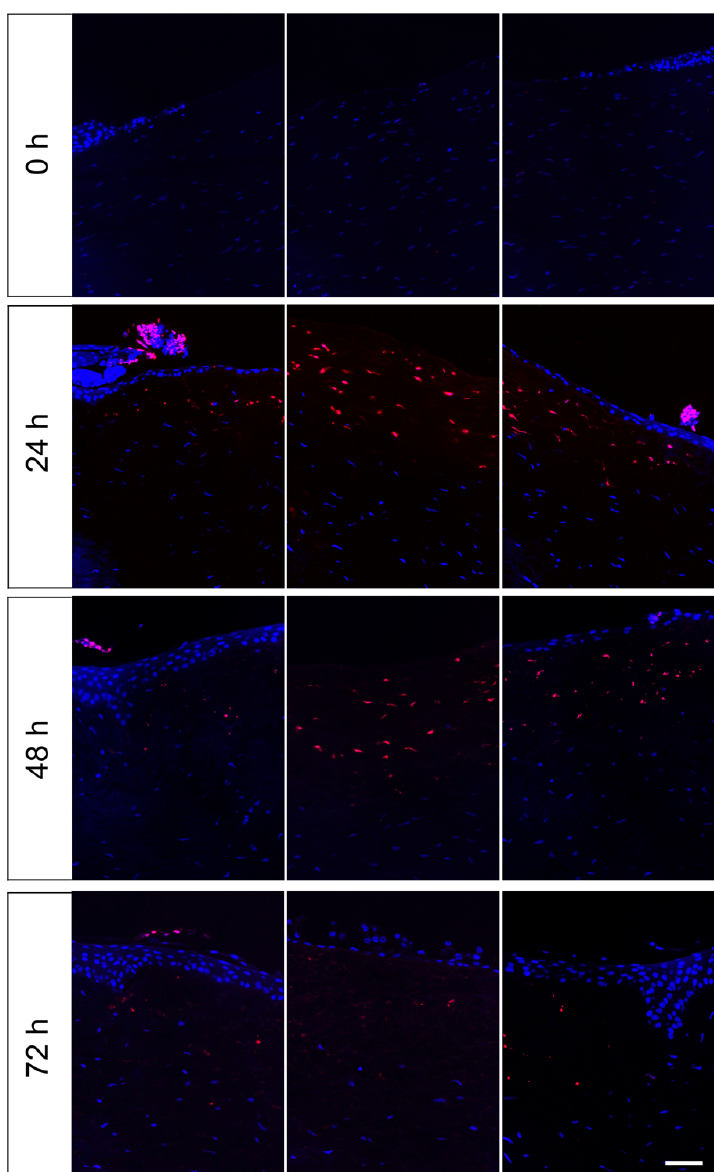
Figure 4. TUNEL-Assay on paraffin sections of the organ culture model after 0 h, 24 h, 48 h and 72 h. Apoptotic cells in cornea paraffin sections were determined at the start of the culture (0 h) and during ex vivo cultivation on days 1–3. Specimens had been cultured in DMEM and the lesion had a diameter of 4 mm. Images present the left wound margin (left panels), the centre of the defect (middle panels) and the right wound margin (right panels). Apoptotic cells were stained with TMR (red) and all cell nuclei were stained with DAPI (blue). Scale bar represents 50 µm.